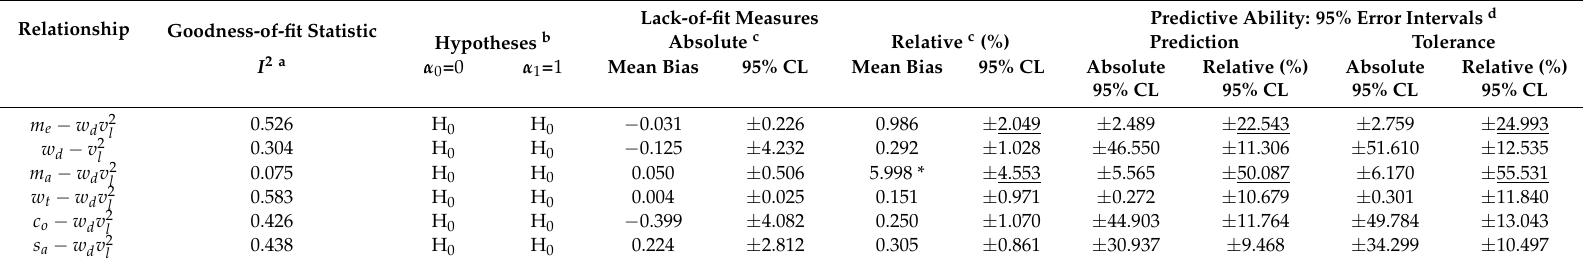
Table 8. Evaluation metrics for the parameterized models: goodness-of-fit, lack-of-fit statistics and predictive ability metrics.